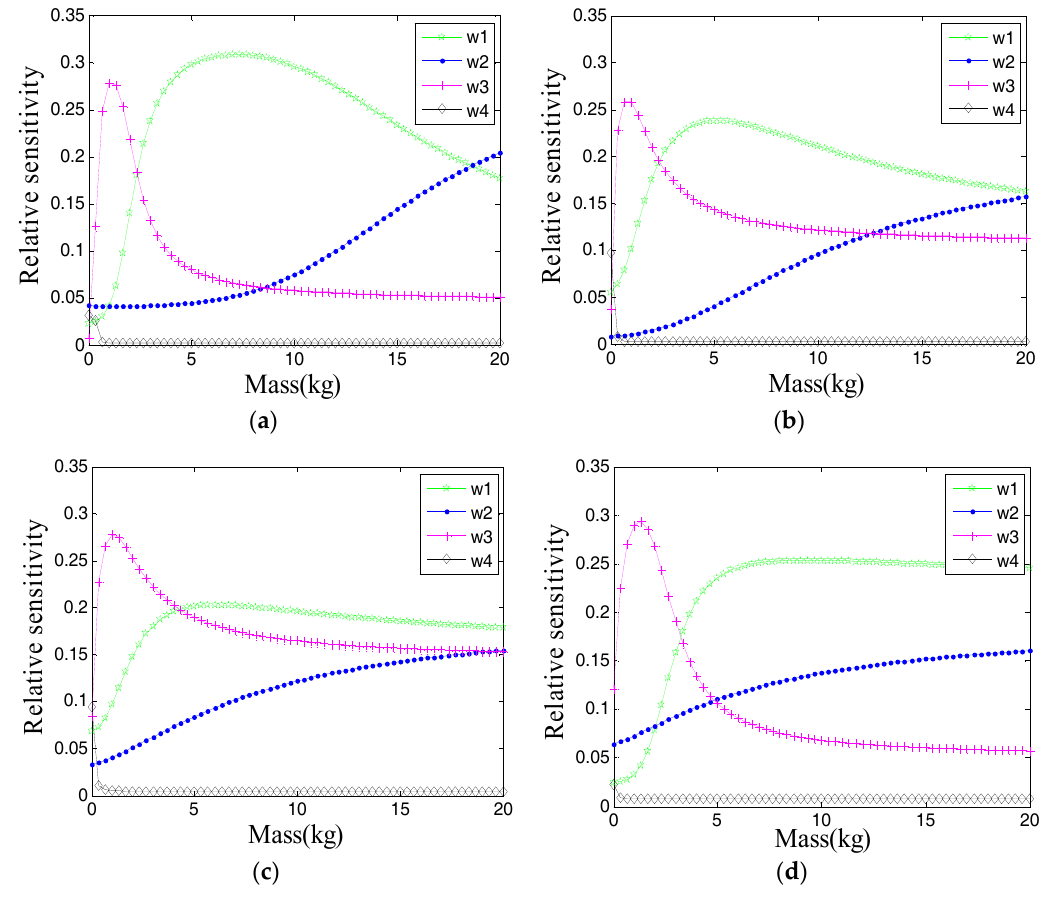
Figure 3. Relationship between relative sensitivity and mass. ( a ) Substructure: 1/2/9/10; ( b ) Substructure: 3/8; ( c ) Substructure: 4/7; ( d ) Substructure: 5/6.